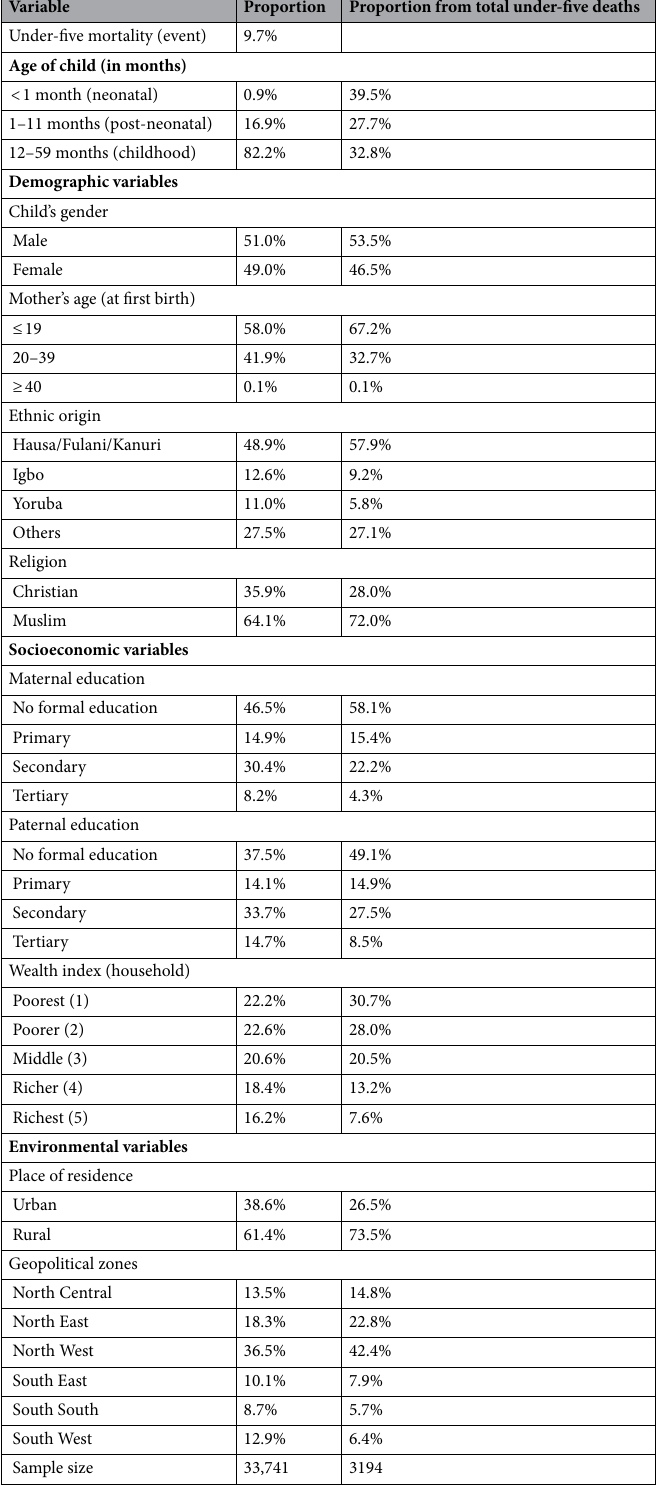
Table 2. Descriptive statistics of variables used in the study and distribution of under-five (0–59 months) deaths across the demographic, geographic and socioeconomic